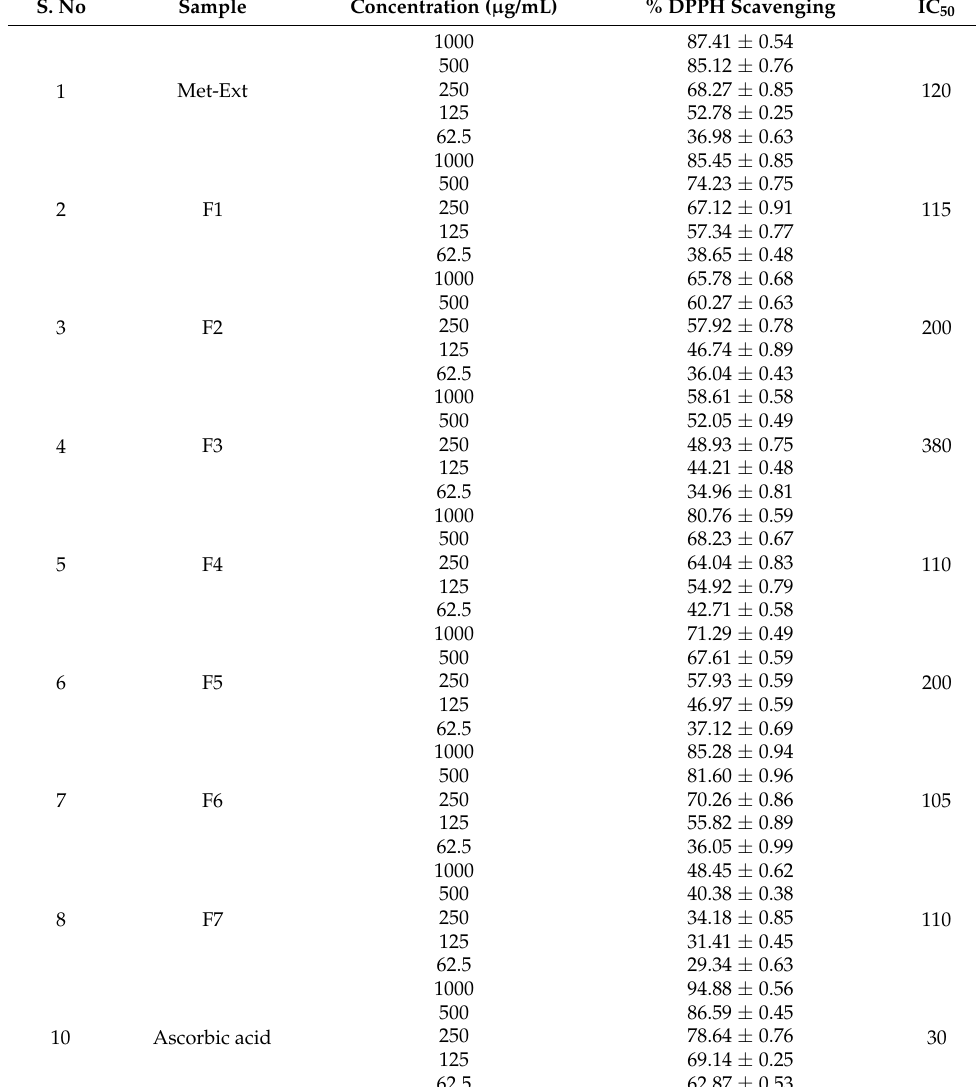
Table 5. DPPH free radical scavenging potential of Cydonia oblonga at various